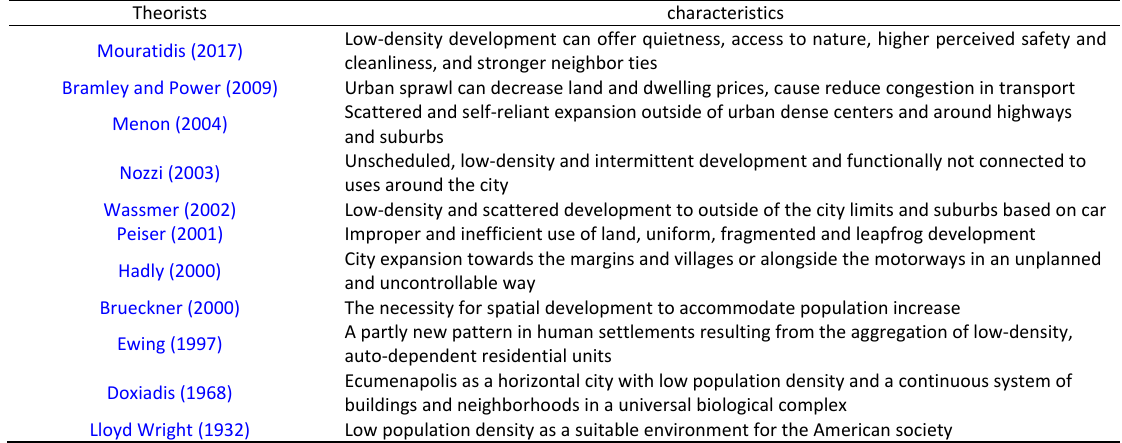
Table 1: Urban sprawl characteristics